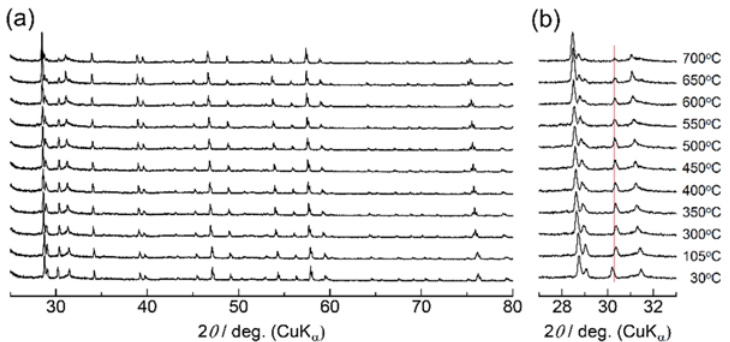
Figure 8. ( a ) High-temperature X-ray diffraction patterns of Ca 1 − x K x WO 4 − x/2 ( x = 0.4); ( b ) Diffraction pattern enlarged in the range 27°–33°.